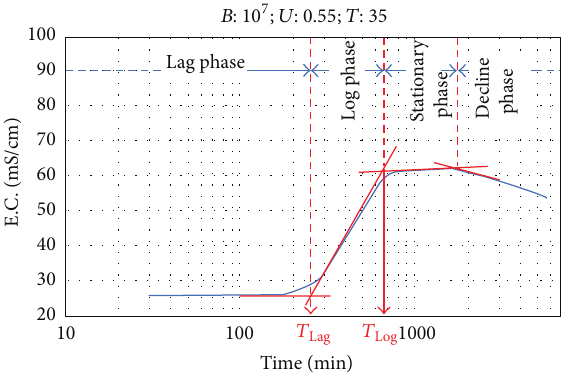
Figure 4: Description of microbial urea hydrolysis pattern which is similar to microbial growth curve.